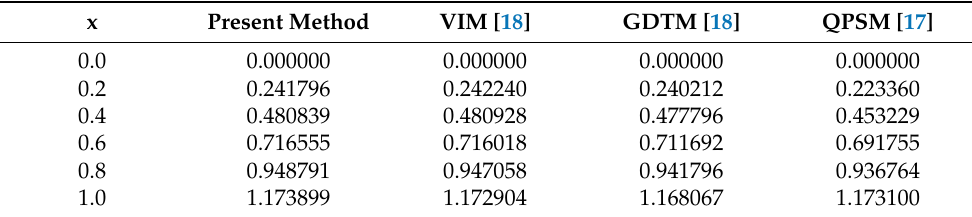
Table 2. The comparison between the proposed method and other existing methods for t = 0.2 and various x values.